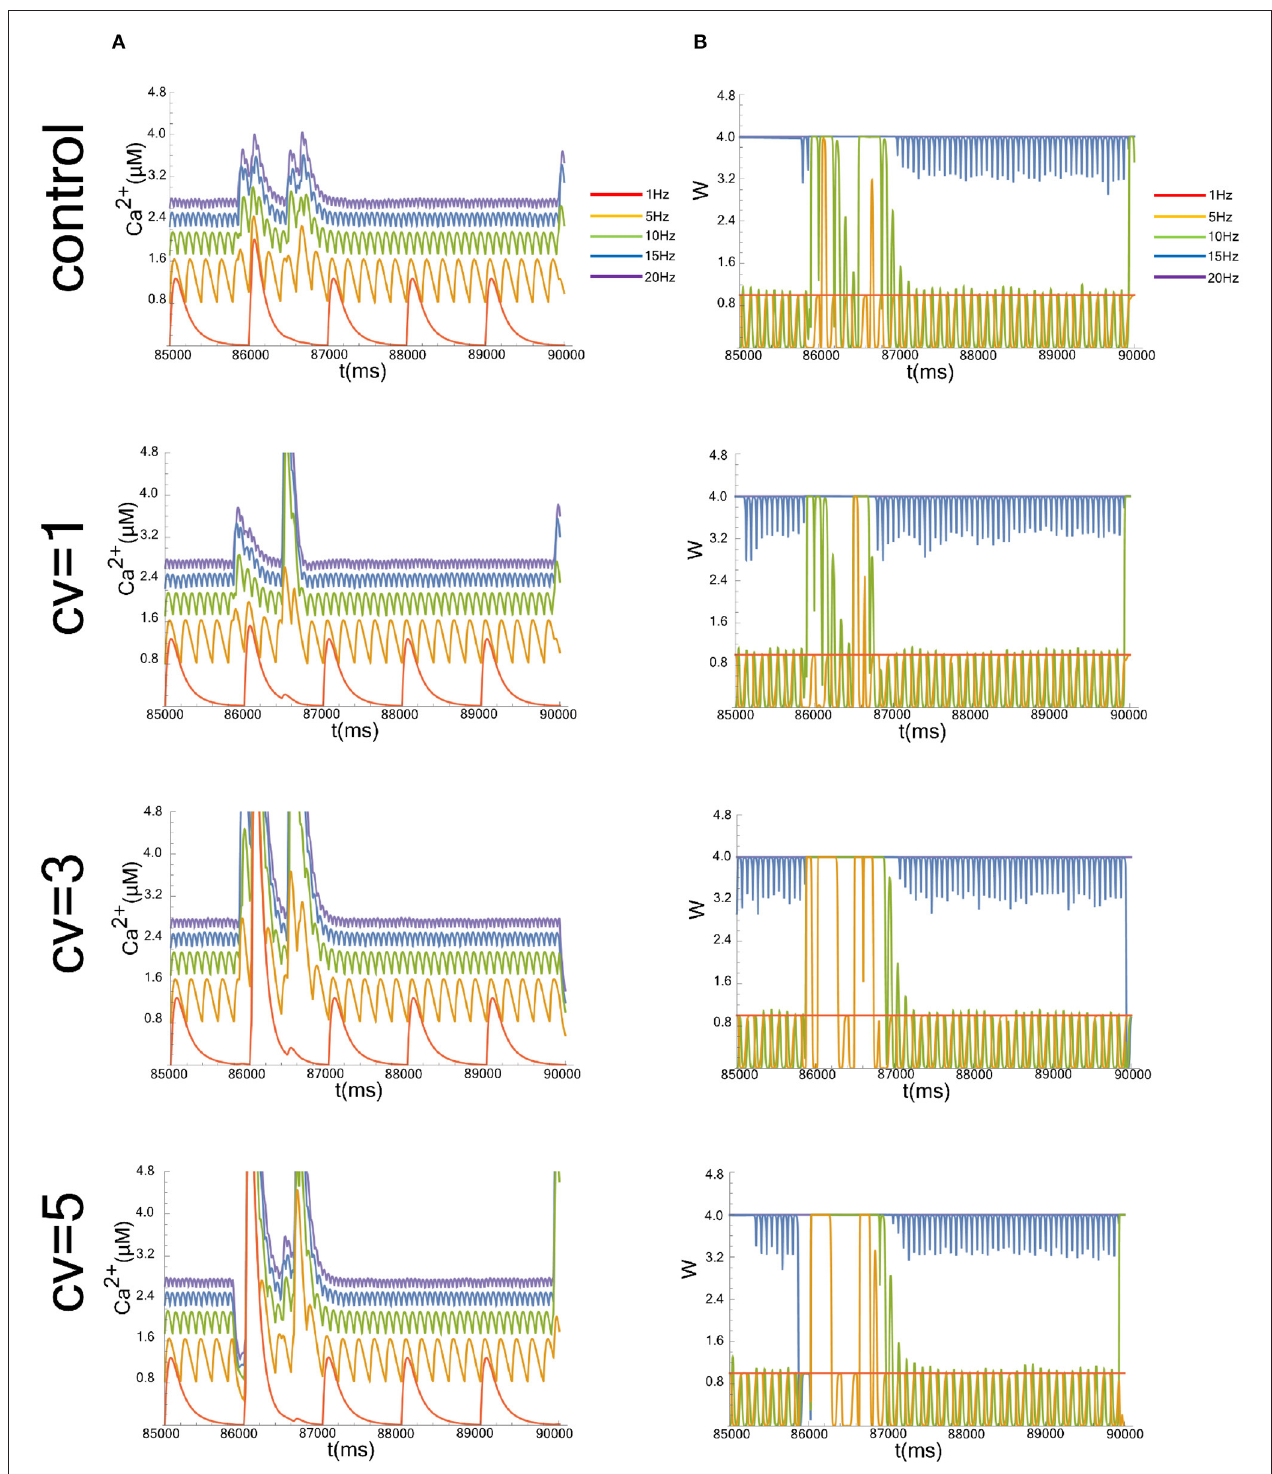
FIGURE 1 | Typical simulation results, showing time evolution of the postsynaptic calcium concentration ( Ca 2 + in A ) and synaptic weight ( W in B ). Figures start at 8.5 × 10 4 ms to show a representative simulation result in the time interval over which the average is taken. We evaluated the case that the CV of the postsynaptic background activity ( V bg ), whose frequency is fixed at 1 Hz, were 1, 3, and 5. The data without the applied fluctuation is shown as a control. The graphs of the cases where the input frequencies are 1, 5, 10, 15, and 20 Hz are superimposed.